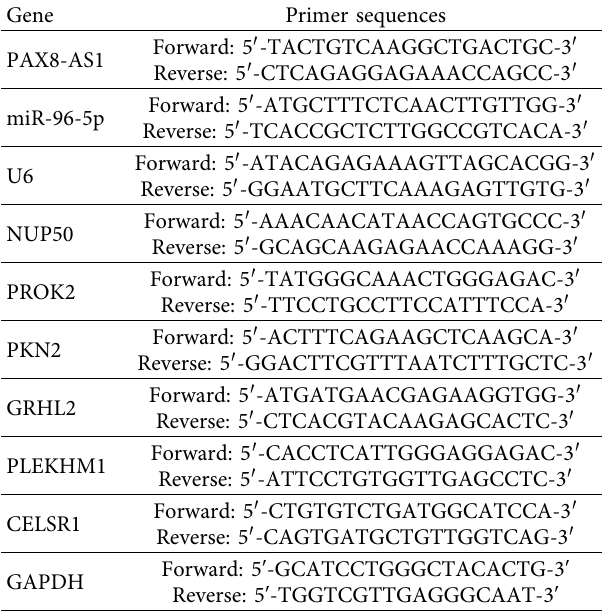
Table 1: The primer